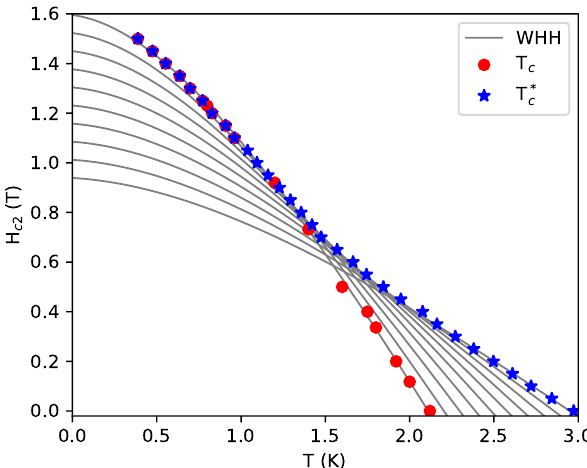
Figure 10. The upper critical field for La 3 Rh 4 Sn 13 compared with results from the percolation model. The blue stars represent resistivity measurements ( T ∗ c ) and the red circles were determined from heat capacity measurements. The gray lines show WHH solutions under the assumption that H c 2 ( T = 0 ) = aT c ( H = 0 ) + b , with a < 0. Parameters a and b were fitted to reproduce the resistive superconducting